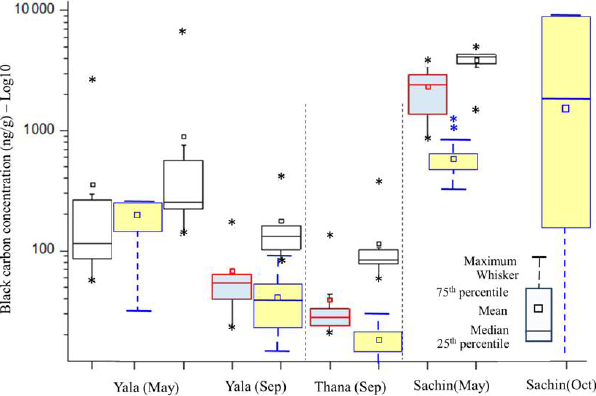
Figure 2. Box-and-whisker plots of black carbon (red box) and or- ganic carbon (black box) concentrations (ngg − 1 ) in snow samples collected from three different glaciers in spring and autumn 2016. The yellow boxes represent BC content in surface snow from WRF- Chem simulations. Stars (*) represent